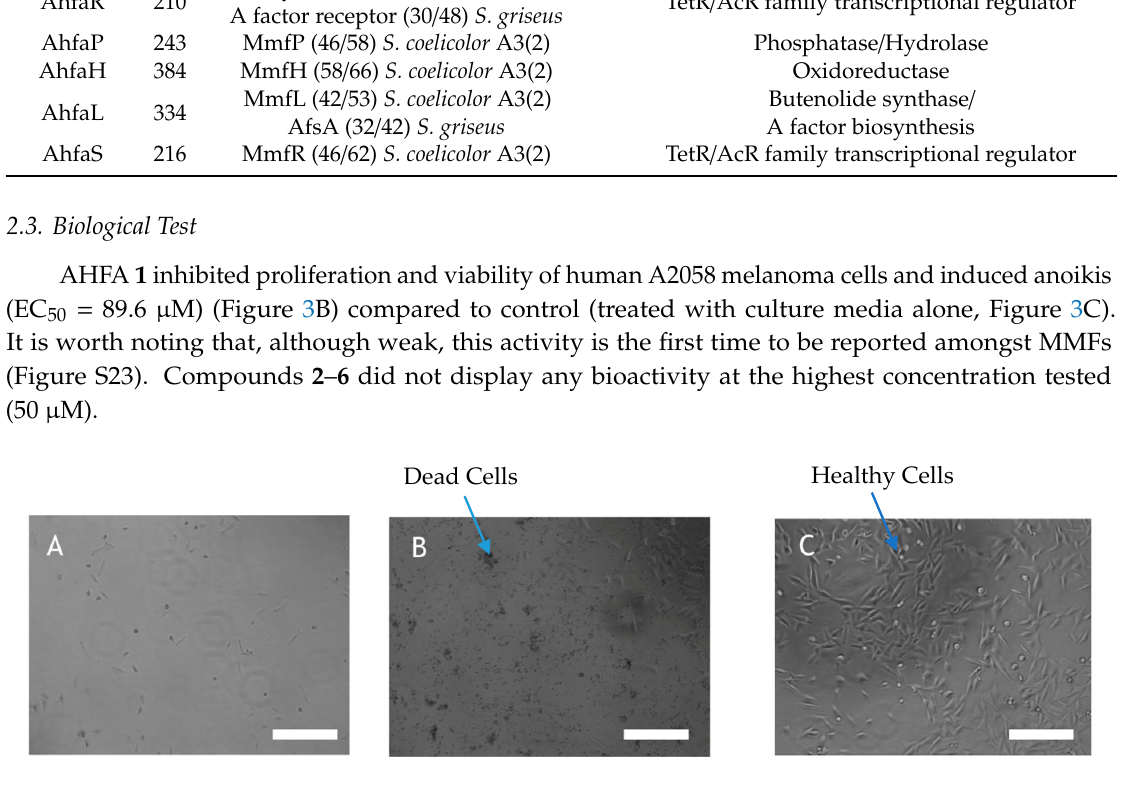
Figure 3. ( A ) A2058 cell treated with 50 µ g / mL staurosporine ( B ) A2058 cell treated with 50 µ g /